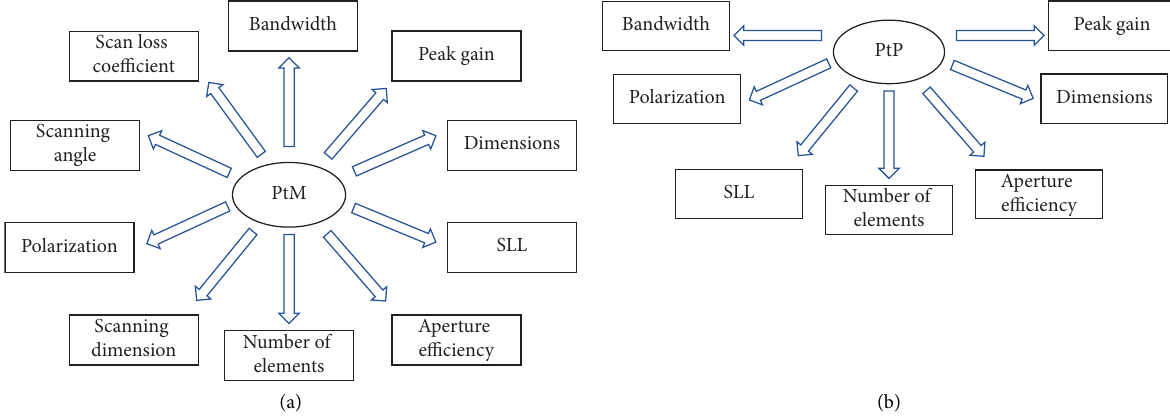
Figure 2: Figures of merit for the analysis of antenna arrays for (a) point-to-multipoint (PtM) communications and (b) point-to-point (PtP)